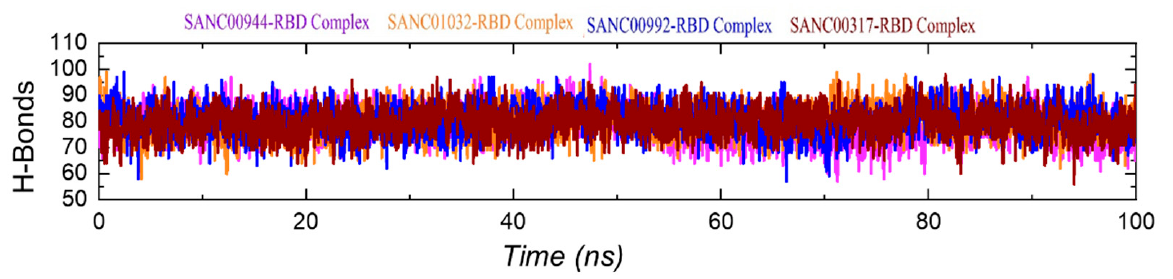
Figure 9. ( A ) Residual flexibility analysis of the SANC01032–RBD, SANC01032–RBD, SANC00992– RBD, and SANC00317–RBD complexes and Apo RBD. ( B ) Flexibility indices of the three binding loops (484–500) required for interactions.